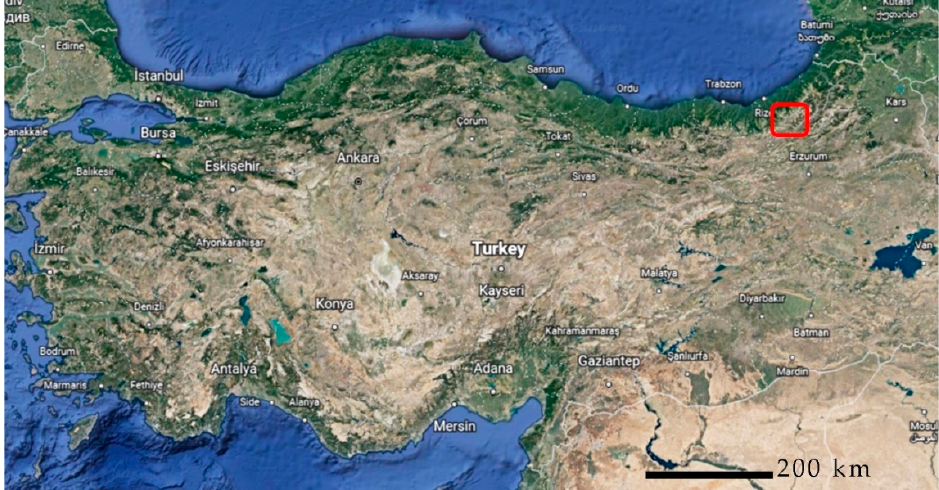
Figure 1. The location of the study area, red square.